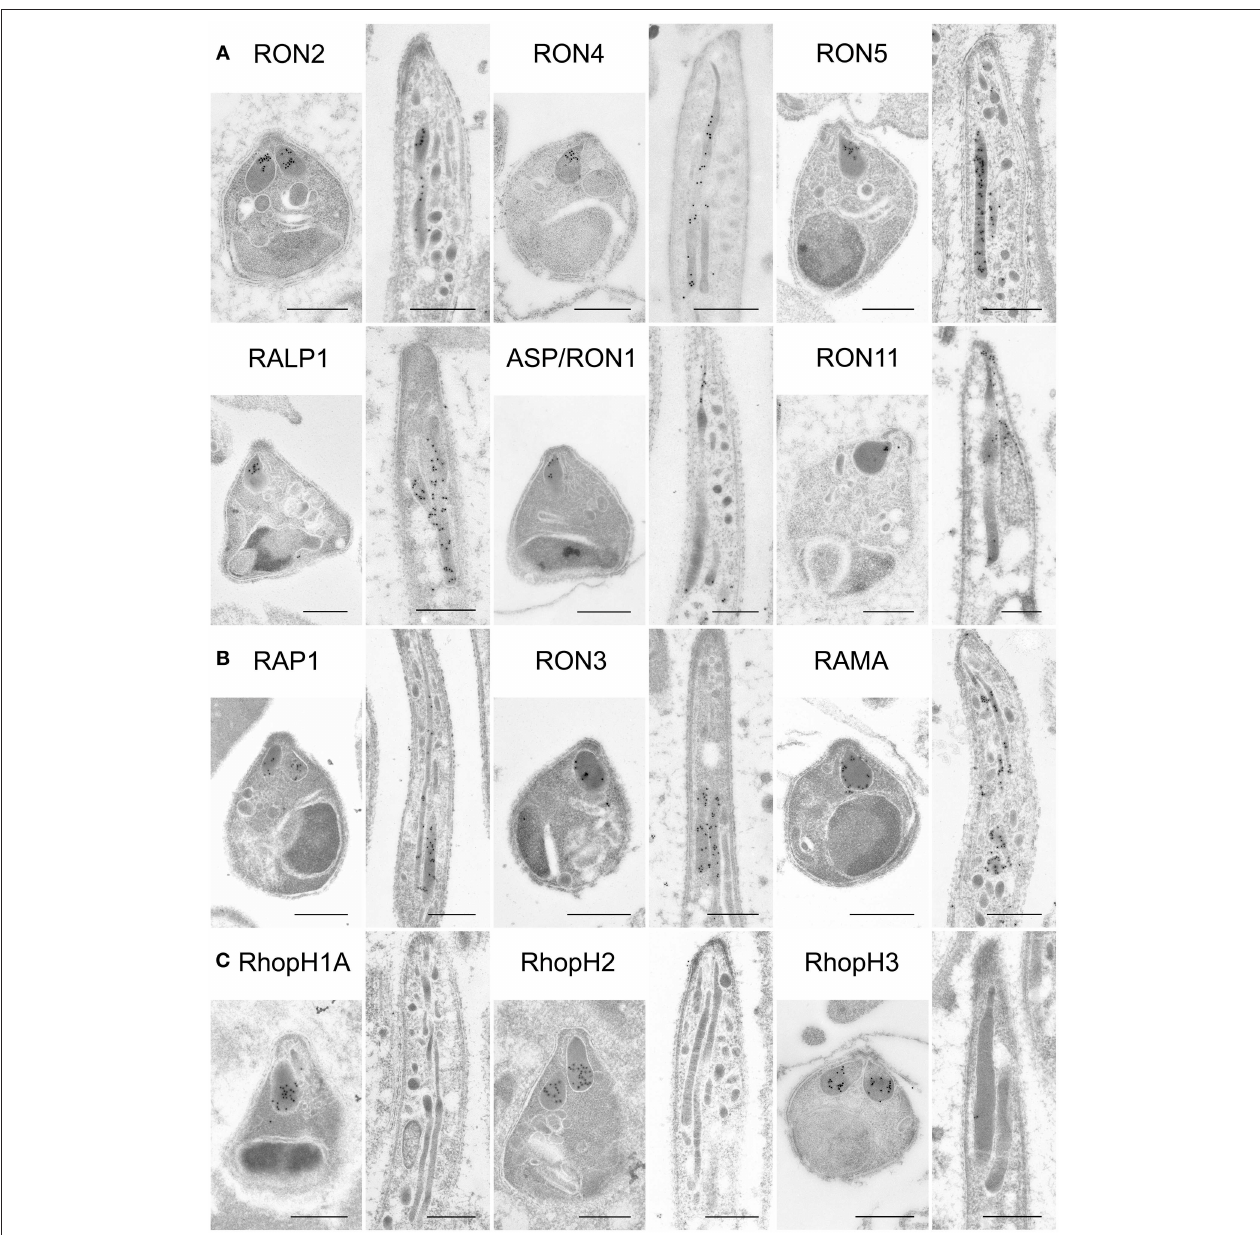
FIGURE 4 | Localization analyses of rhoptry proteins in merozoites and sporozoites by immuno-electron microscopy. Longitudinally sectioned merozoites in cultivated schizonts and oocyst-derived sporozoites (at day 17 or 21 post-feeding) of each transgenic parasite line or WT-GFP were prepared for IEM analyses. Target proteins were detected by incubation with anti-c-Myc rabbit antibodies or specific antibodies against ASP/RON1 or RAMA, followed by secondary antibodies conjugated to gold particles. (A) A group of rhoptry proteins categorized as rhoptry neck proteins in merozoites. All examined proteins are confirmed to be localized to the rhoptry neck region in P. berghei merozoites. In contrast, most of them, except ASP/RON1, are distributed throughout rhoptries in sporozoites, as demonstrated previously regarding RON11. (B) A group of proteins expressed both in merozoites and sporozoites and categorized as rhoptry bulb proteins in merozoites. It is noteworthy that RAMA localizes to the rhoptry membrane in merozoites. In sporozoites, they are distributed in the rhoptry body region. (C) A group of proteins categorized as rhoptry bulb proteins in merozoites, which are produced predominantly in merozoites. IEM confirmed that none of them, RhopH1A, RhopH2, and RhopH3, are localized to rhoptries in sporozoites, despite their clear localization to the rhoptry bulb in merozoites. Bars, 500nm.